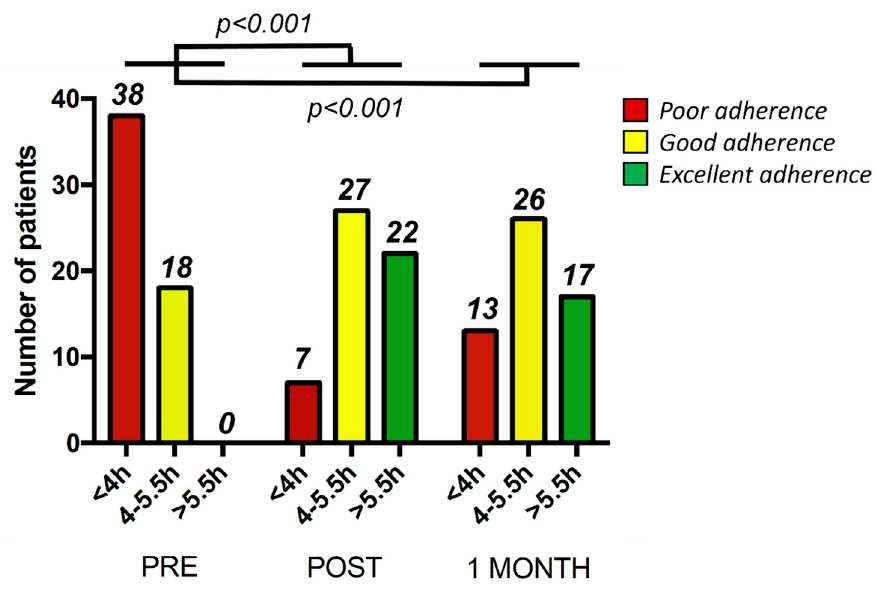
Figure 3. Number of patients within three different levels of adherence: poor and thus poor adherence (<4 h/night) (red), good adherence (4–5.5 h/night) (yellow) and excellent adherence (>5.5 h/night) (green) at three different time points: prior to the telemedicine intervention (Pre), after the intervention (Post) and one month later (1 month). The p values refer to differences in the number of patients within three different levels of adherence when comparing PRE vs. POST and PRE vs. 1-MONTH.